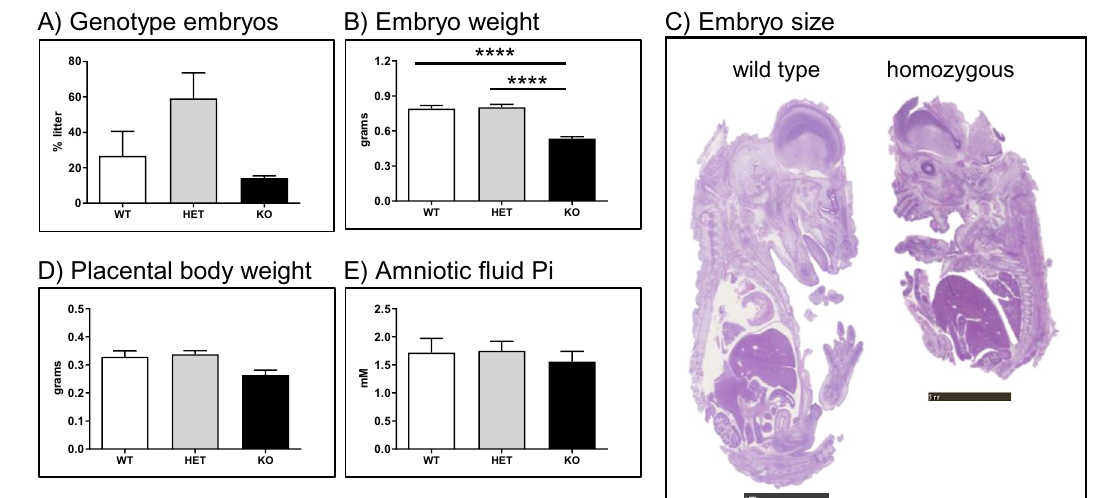
Figure 5. ( A ) Genotype of E18 embryos born from 3 heterozygous breedings. Embryonic ( B ) body weight, ( C ) representative images, ( D ) placental body weight and ( E ) amniotic fluid Pi concentration. Data are presented as means ± SEM. Scale bars in ( C ): 5 mm. Statistical significance was calculated by ANOVA-Bonferroni. **** P ≤ 0.0001.